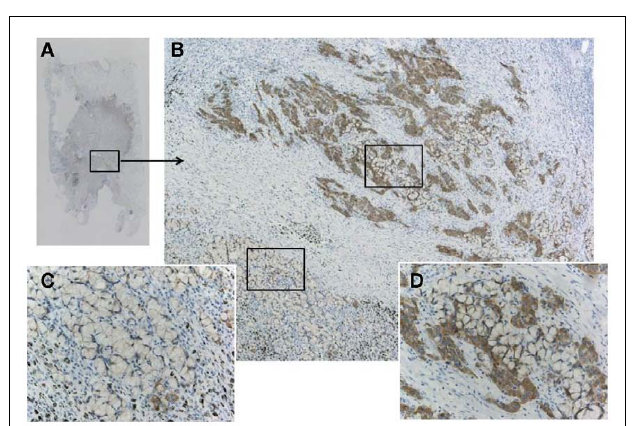
FIGURE 6 |A case ofALK-IHC positive small cell lung cancer. A lung nodule was biopsied from the 83-year-old female smoker. H&E section (A) shows typical morphology of small cell lung cancer and CD56/NCAM and synaptophysin were positive. Although it is little